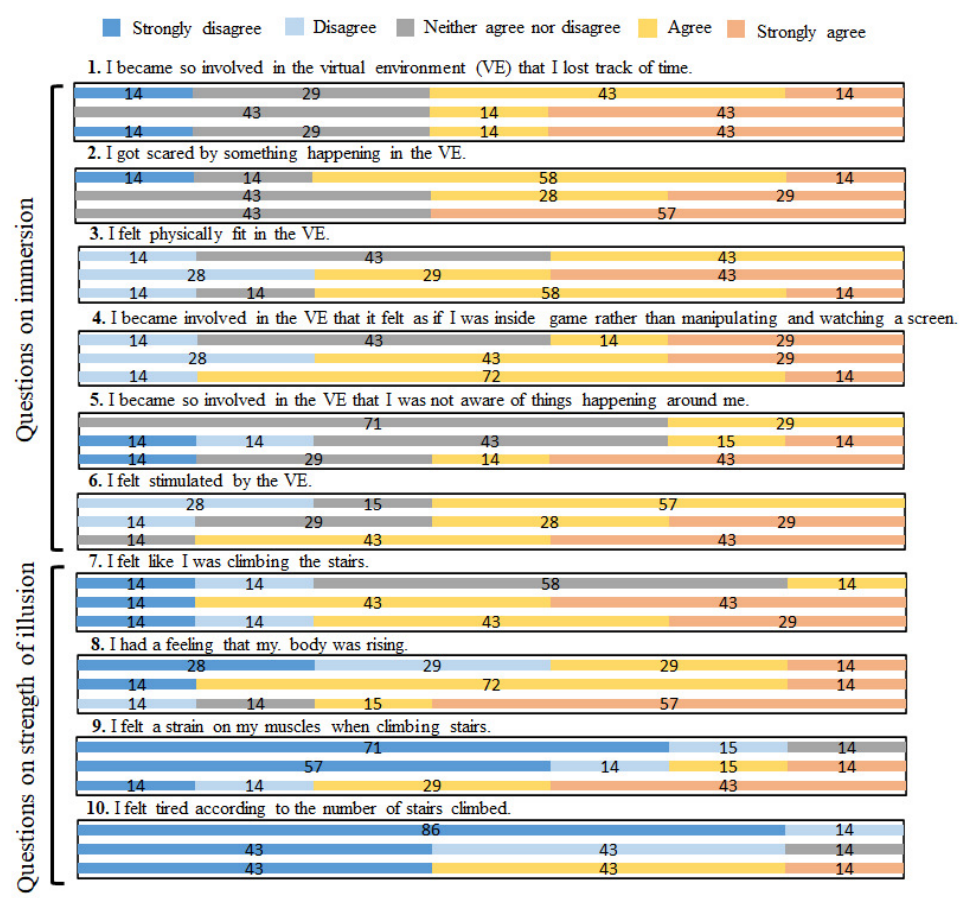
Figure 13. Questions and responses in the questionnaire (all responses are expressed as percentages of participants who selected the specific